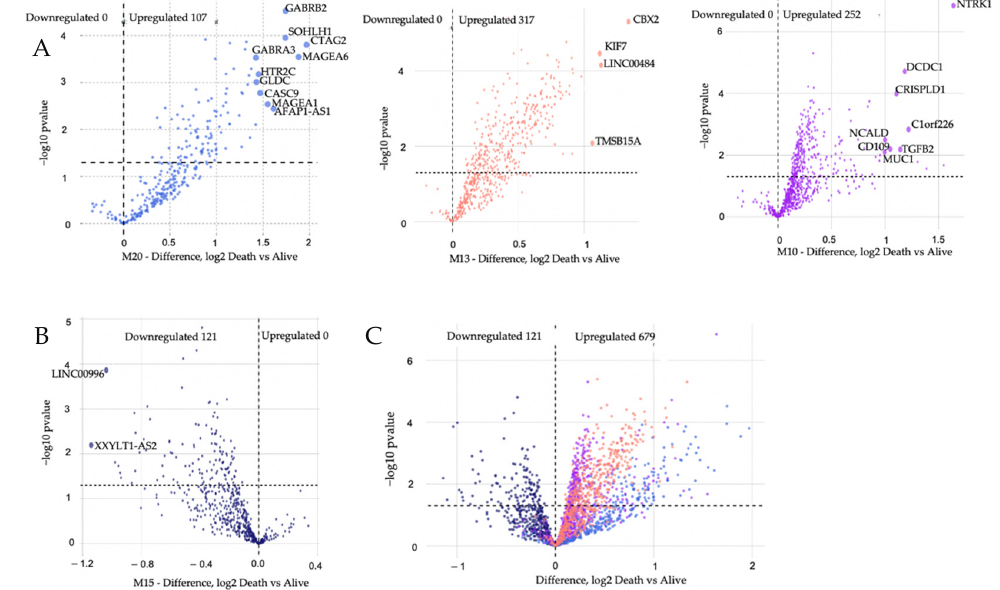
Figure 5. Volcano plots of differential gene expression identify gene transcripts that contain upregulated genes, panel ( A ), downregulated genes, panel ( B ), and both upregulated and downregulated genes, panel ( C ), based on MM vital status for biologically significant modules. The number of downregulated genestranscripts is denoted on the left and the number of upregulated gene transcripts is denoted on the right. The total number of upregulated genes is 676, while the total number of downregulated genes is 121. The log2 fold change is plotted on the X -axis, and the negative log10 p -value is plotted on the y -axis. Gene transcripts are colored by module